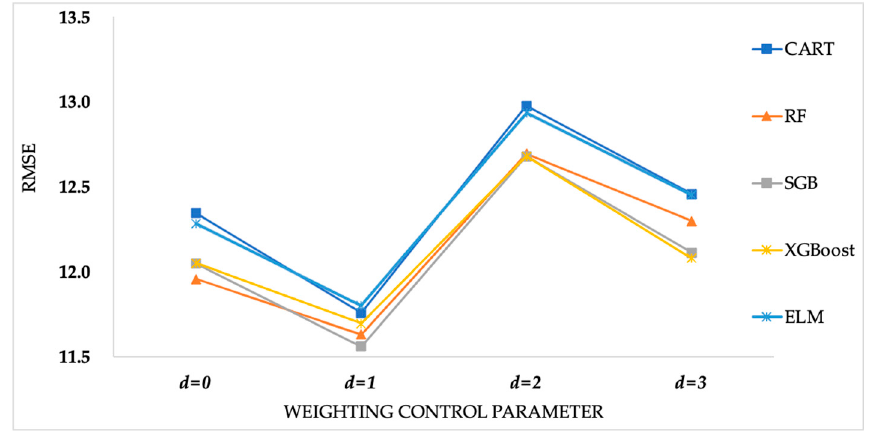
Figure 7. Prediction performance of prediction models with weighting control parameter ( d ) from 0 to 3 under game-lag ( l ) =